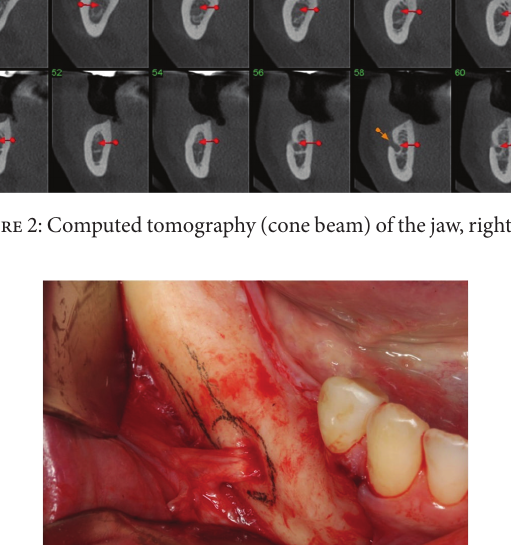
Figure 3: Definition of the mental foramen and the mandibular canal.